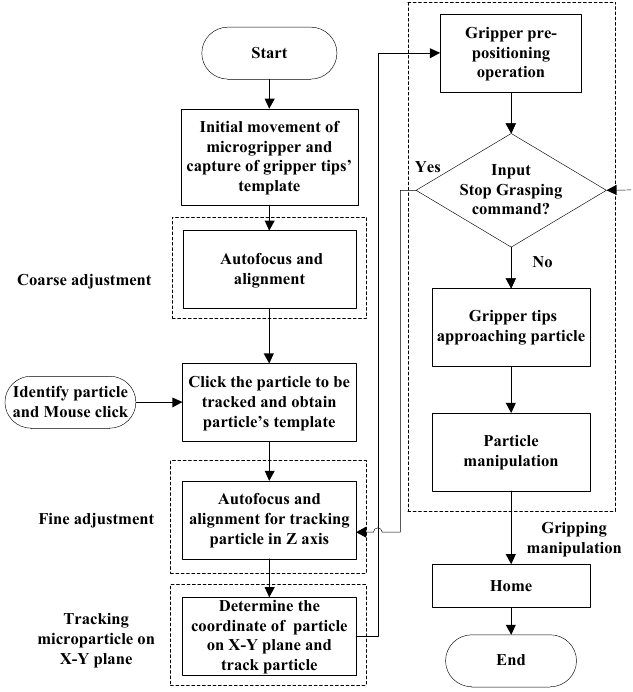
Figure 13. The processes of tracking and gripping particle moving in 3-D space.